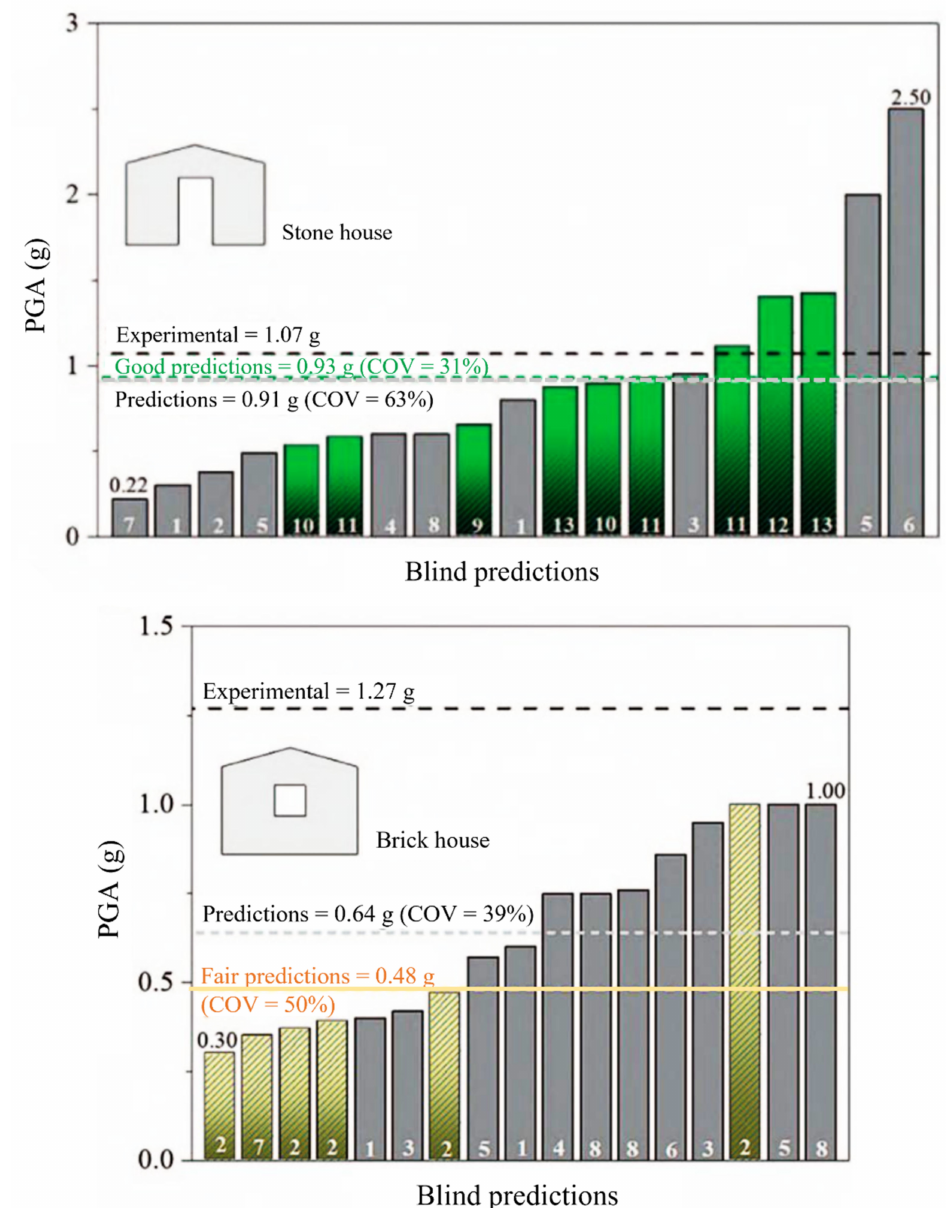
Figure 12. Seismic acceleration capacity (PGA) obtained from the blind predictions [98] (green and yellow bars correspond to good and fair mechanism